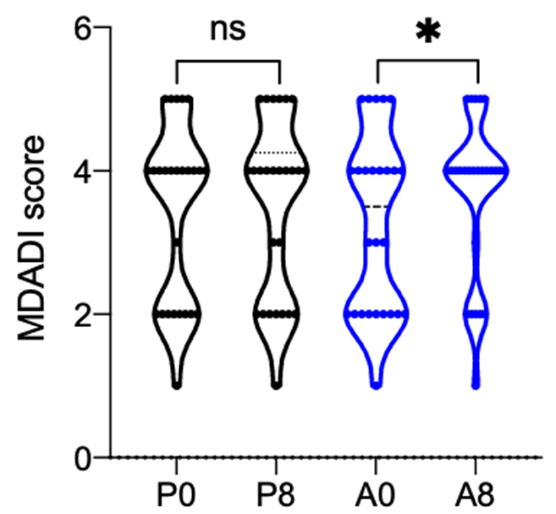
Figure 3. Violin plot of MDADI global score. MDADI global score recorded before (P0,A0) and after one week (P8,A8) of treatment. P is for placebo, A for Aqualief TM , * p < 0.1, ns, no significant differences. Statistical analysis between the two time points of the same group was performed by paired t -test, between the two groups by unpaired t -test.